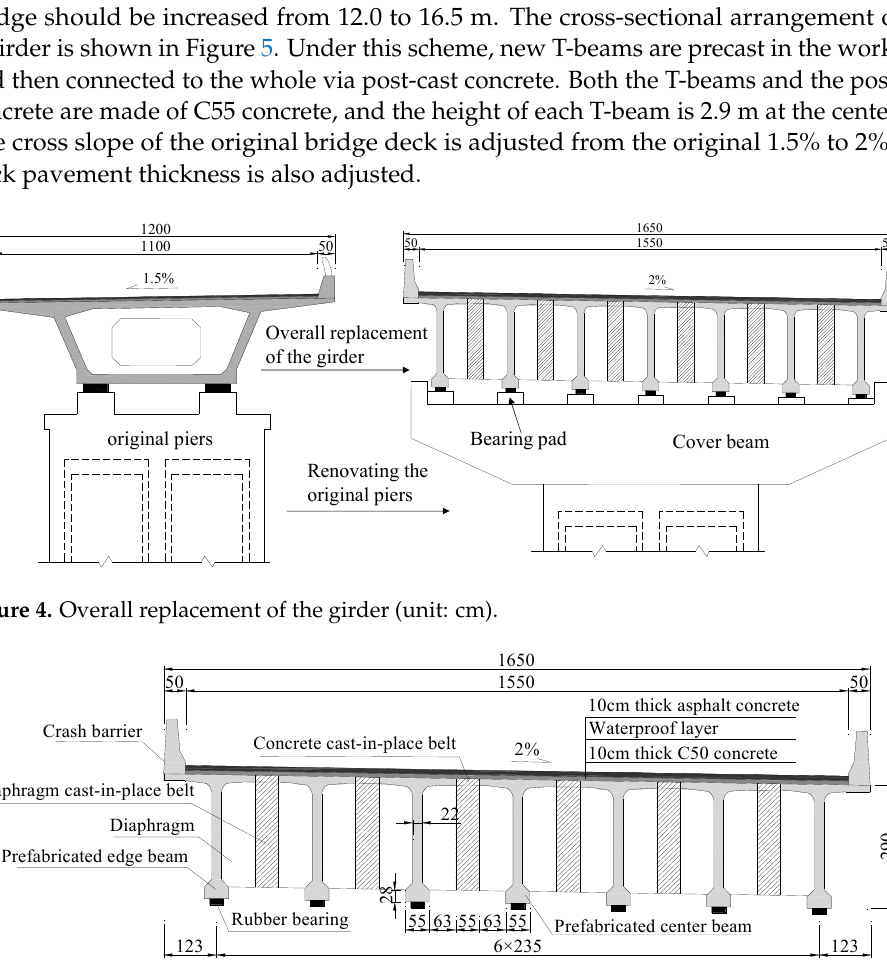
Figure 5. Scheme 1 cross section layout of bridge (unit: cm).